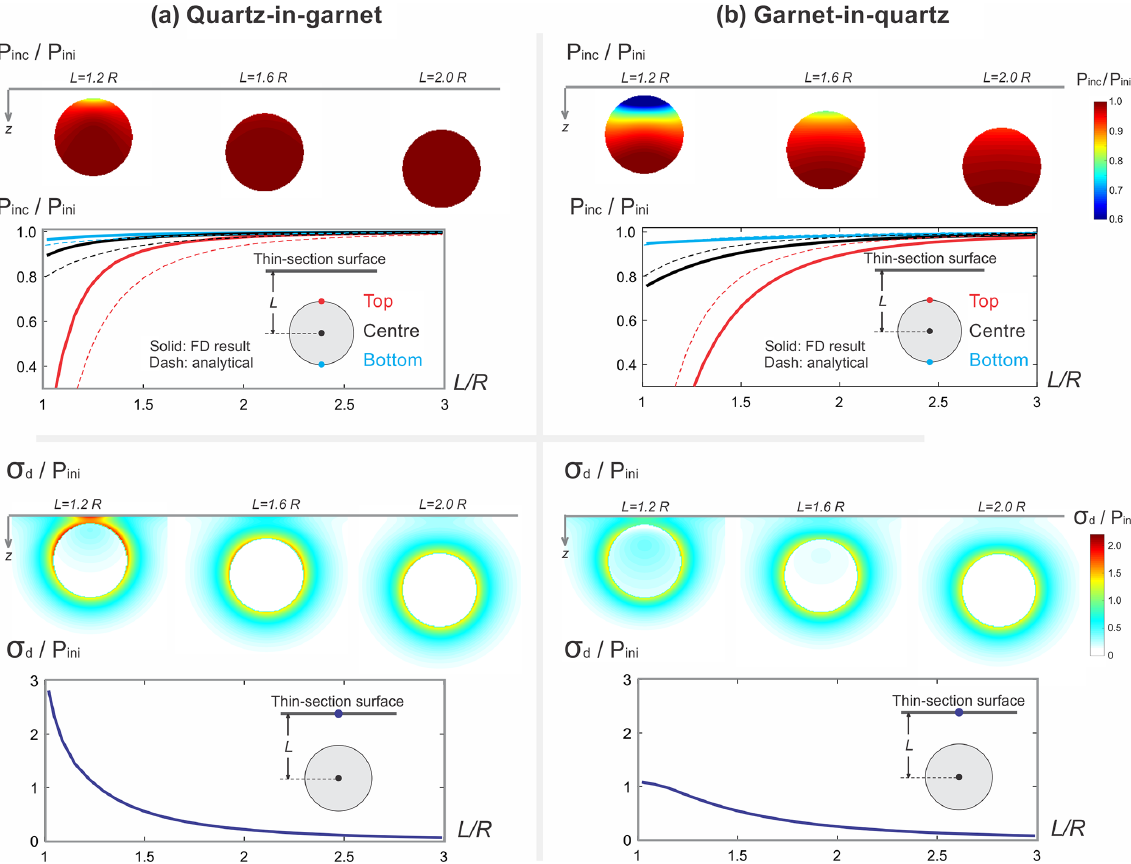
Figure 8. Dimensionless pressure and differential stress plotted on an x – z plane or as a function of dimensionless depth. (a) Quartz-in- almandine system; (b) almandine-in-quartz system. For the profiles, pressure and differential stress are measured at different locations denoted by the coloured dots. In the top panel, the dashed curves in the pressure plot are based on the analytical solution in Eq. (22) considering the same elastic moduli between inclusion and host, while the solid curves are based on finite-difference results. The discrepancy between the solid (numerical solution) and dashed (analytical solution) curves in (a) is due to the fact that the host elasticity is different from the